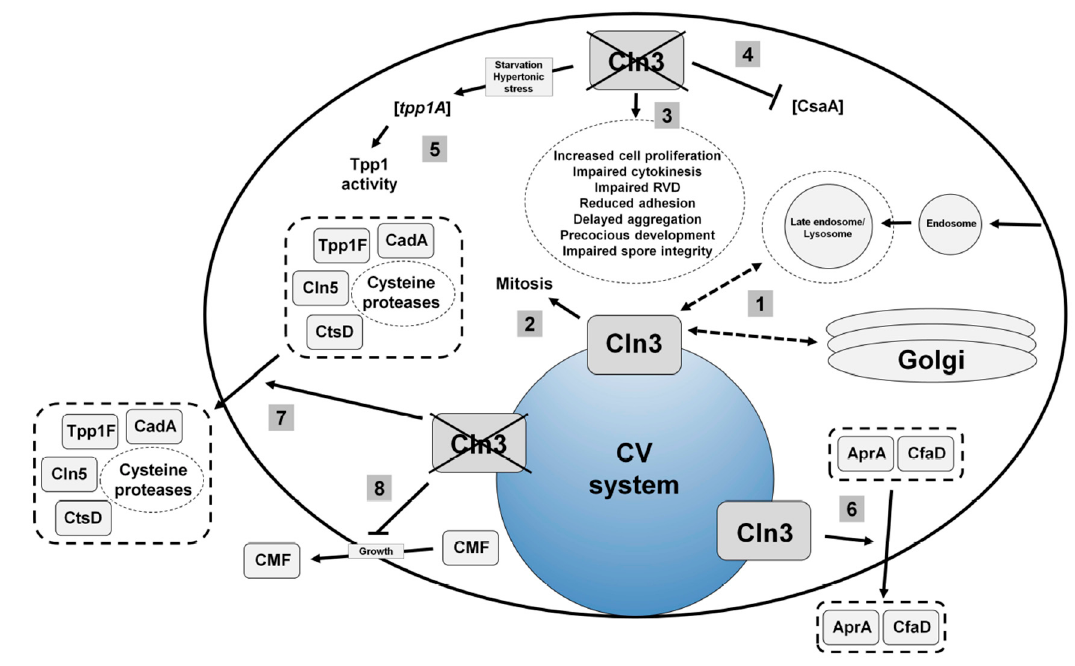
Figure 3. Current model of Cln3 function in Dictyostelium . (1) Cln3 localizes primarily to the contractile vacuole (CV) system, and to a smaller extent, compartments of the endocytic pathway and the Golgi complex. (2) Cln3 function is linked to mitosis. (3) Loss of cln3 increases the rate of cell proliferation, alters cytokinesis, decreases the efficiency of regulatory volume decrease (RVD), reduces adhesion, delays aggregation, causes cells to develop precociously, and impairs spore integrity. (4) Loss of cln3 reduces the intracellular level of CsaA protein. (5) Loss of cln3 increases the expression of tpp1A during osmotic stress and increases TPP1 enzymatic activity. (6) Cln3 modulates the secretion of AprA and CfaD. (7) Loss of cln3 increases the secretion of Tpp1F, Cln5, CtsD, CadA, and selected cysteine proteases. (8) Loss of cln3 reduces the secretion of CMF during